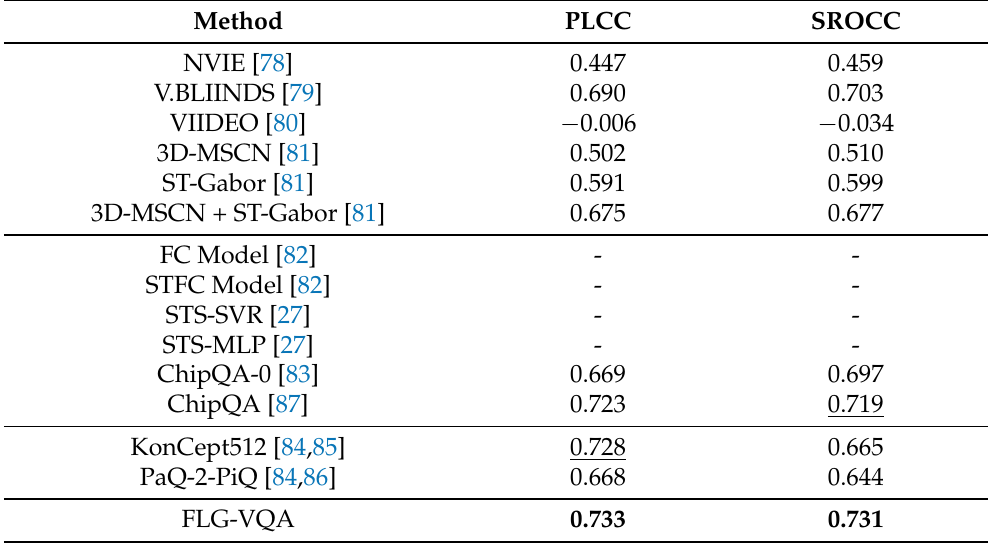
Table 4. Comparison of FLG-VQA with the state-of-the-art methods on LIVE VQC [17]. The median PLCC and SROCC values were measured over 1000 random training–testing splits. The best results are in bold, while the second-best results are underlined. We indicate with “-” when the data are not available.